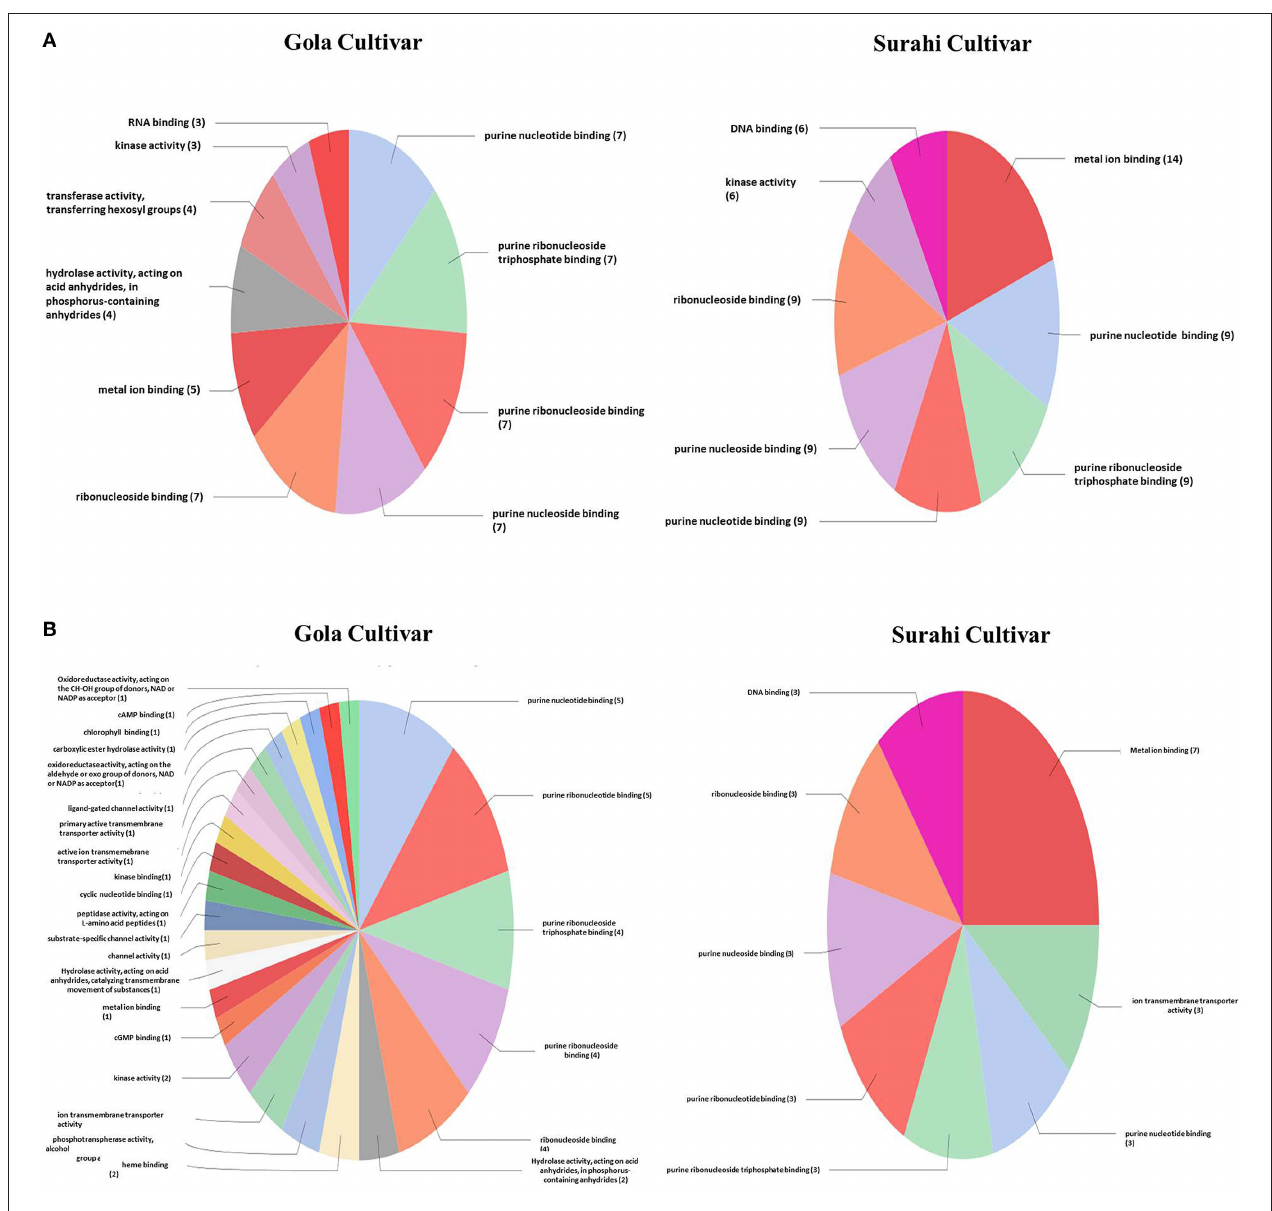
FIGURE 5 | Functional annotation of the upregulated (A) and downregulated (B) ESTs in molecular function of guava under drought